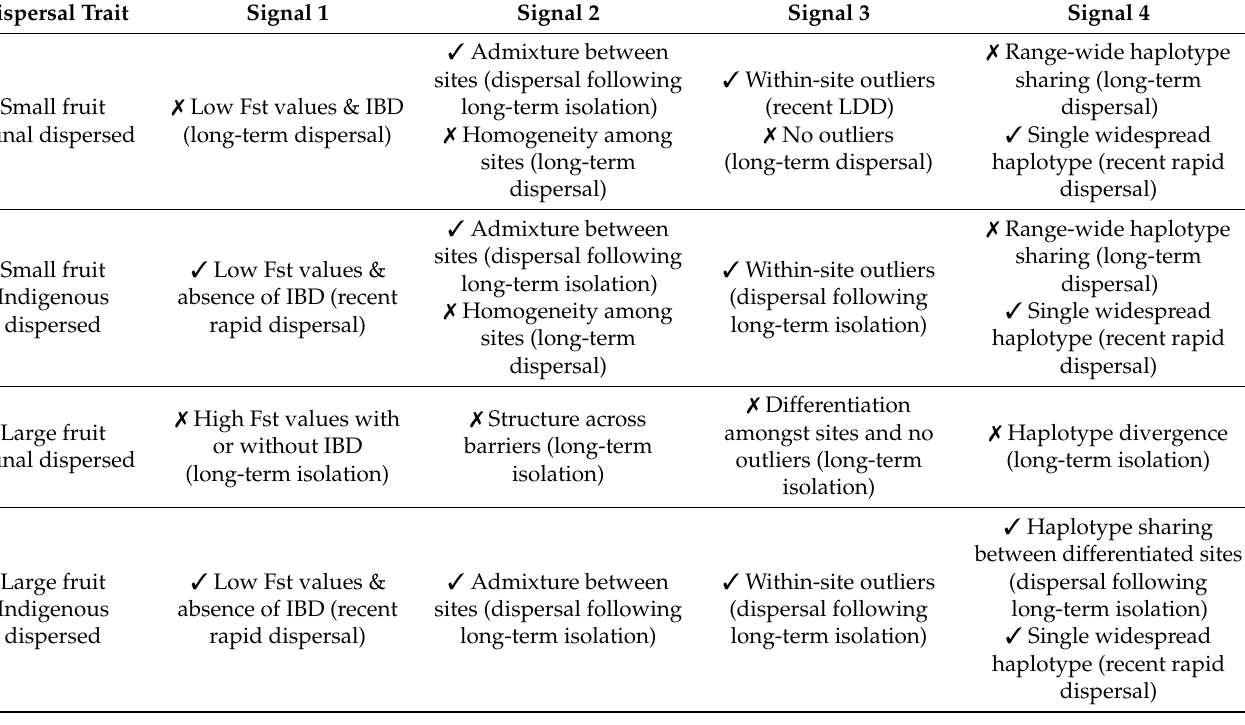
Table 1. The patterns expected from four tests of dispersal assuming different dispersal traits and histories. For each signal, we expected different results for species with a history of long-term isolation, long-term faunal-mediated dispersal or dispersal following long-term isolation. Note that more than one dispersal scenario is hypothesised for species in the small fruit categories. Signal 1 = “low Fst values and absence of isolation-by-distance”. Signal 2 = “admixture between sites”.